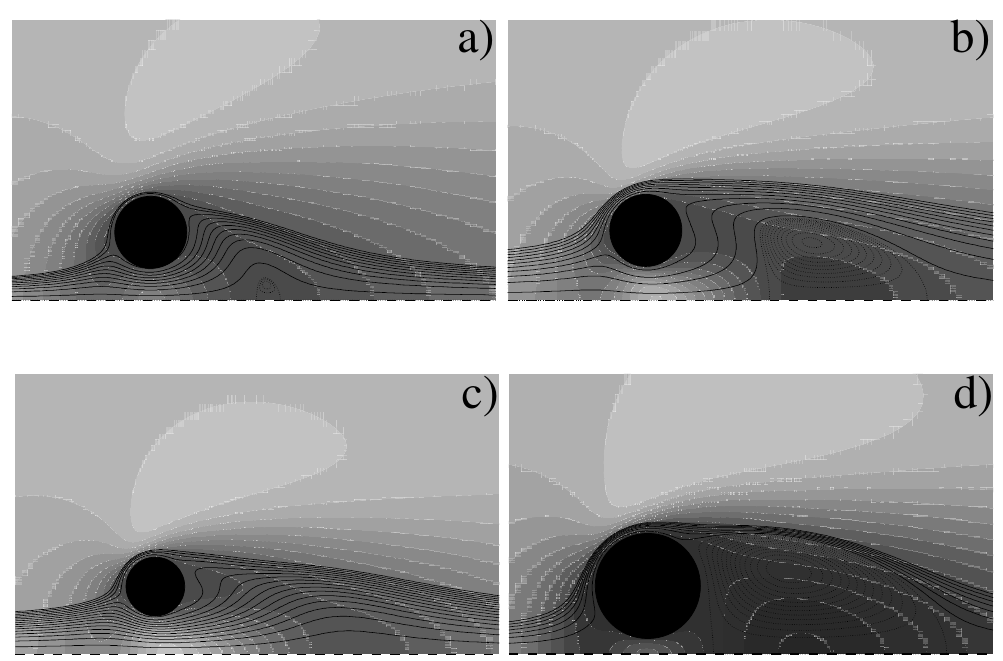
Figure 6. Instantaneous snapshots of streamwise velocity (gray scales) and Stokes streamfunction ( for positive and for negative values) for the flow around a torus: ( a ) Γ = 1, Re = 10; ( b ) Γ = 1, Re = 25; ( c ) Γ = 0.5, Re = 25; ( d ) Γ = 1.5, Re =